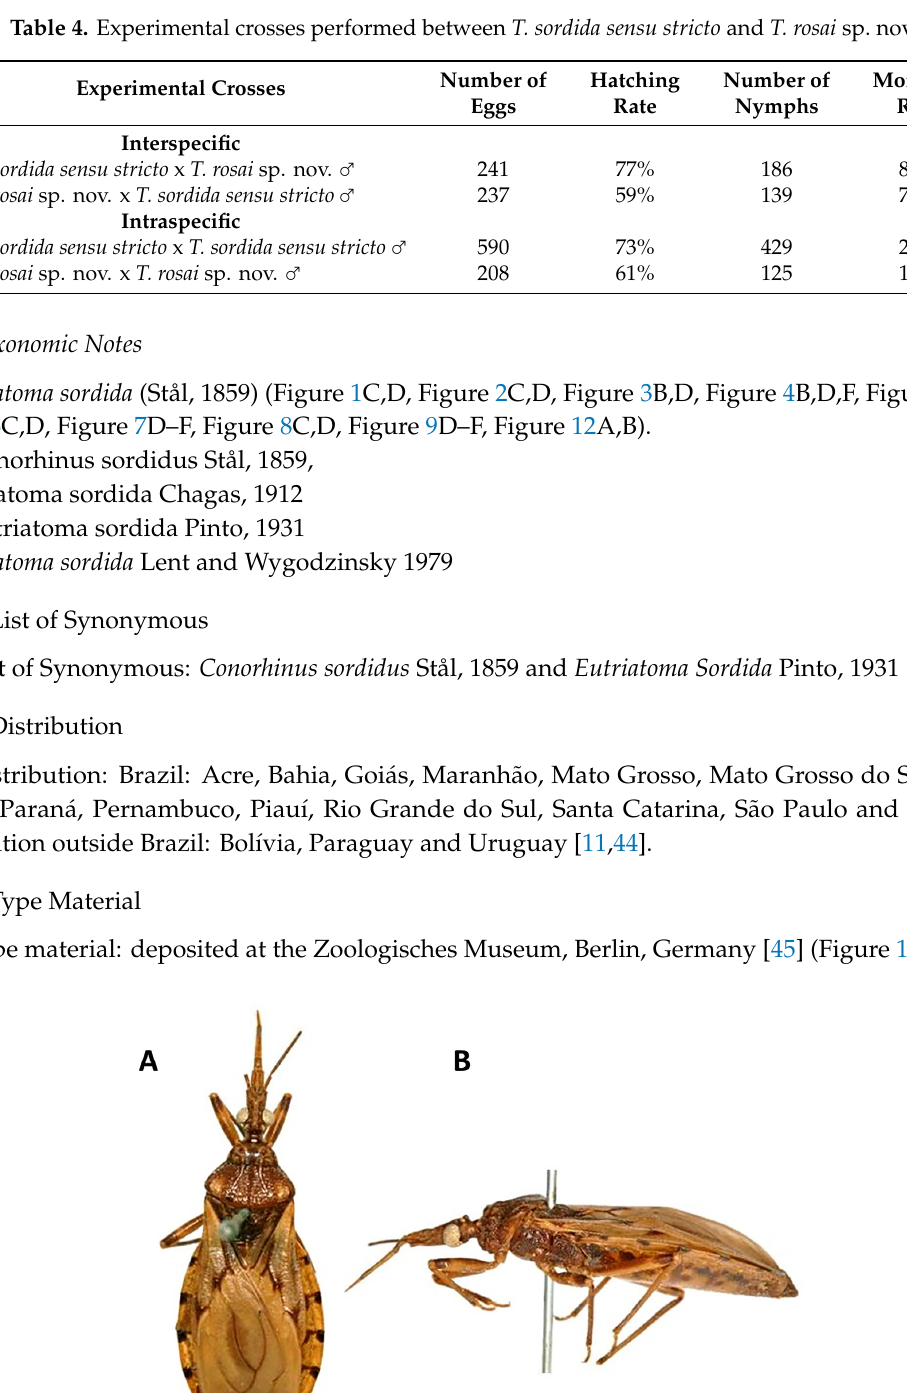
Table 4. Experimental crosses performed between T. sordida sensu stricto and T. rosai sp. nov. Experimental Crosses Number of